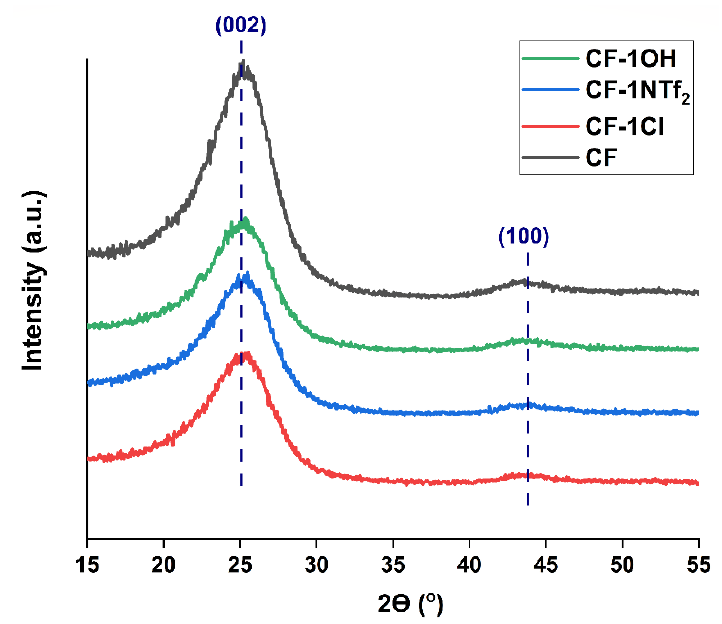
Figure 7 . XRD spectrum of the studied samples and zoomed-in view of the 002 peak. Figure 7. XRD spectrum of the studied samples and zoomed-in view of the 002 peak.